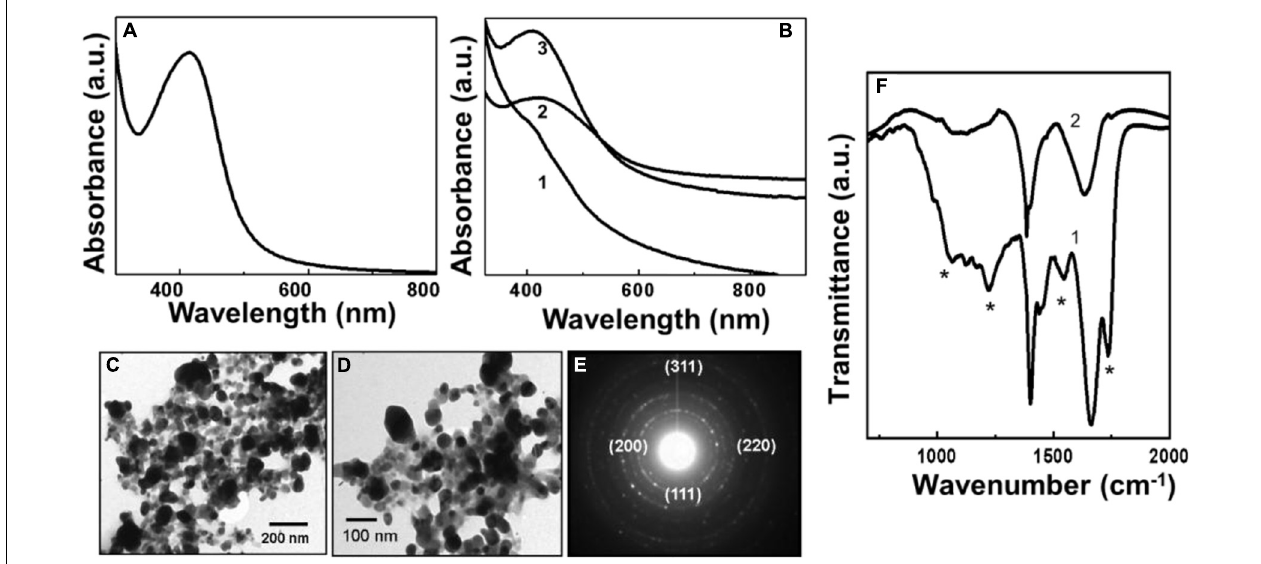
FIGURE 2 | Uv-Vis spectroscopy, transmission electron microscopy (TEM), and Fourier transformed infrared spectroscopy (FTIR) analysis of biologically synthesized pyoverdine silver NPs (Pv-AgNPs). (A) The Uv-Vis spectrum of Pv-AgNPs synthesized after 60 min of reaction between pyoverdine and silver ions. (B) Pv-AgNPs formation kinetics investigated by Uv-Vis absorption spectroscopy. Number 1-3 corresponds to 15, 30, and 60 min of reaction. (C,D) TEM analysis of Pv-AgNPs showing nanoparticles of 20–30 nm diameter and irregularly shaped aggregates of 50–100 nm. (E) Selected area diffraction pattern (SAED) pattern obtained from Py-AgNPs shown in (D) . The numbers in parenthesis indicate the respective crystal planes corresponding to FCC silver. (F) FTIR spectra recorded from pyoverdine before (curve 1) and after (curve 2) the formation of Pv-AgNPs. The * sign indicates vibrations from pyoverdine which are significantly affected after the formation of pv-AgNPs.